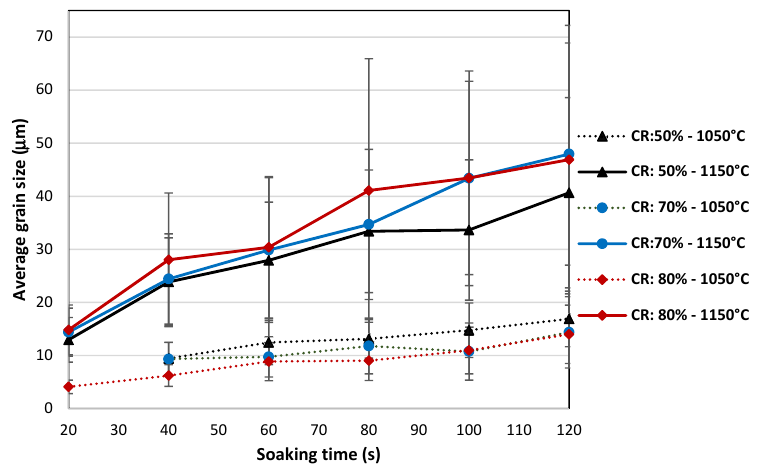
Figure 12. Grain size evolution with process parameters in AISI 904L stainless steel.